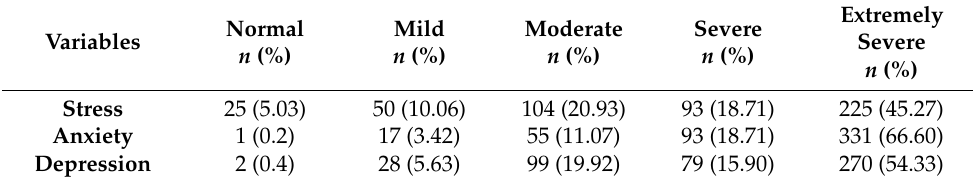
Table 2. The prevalence of stress, anxiety, and